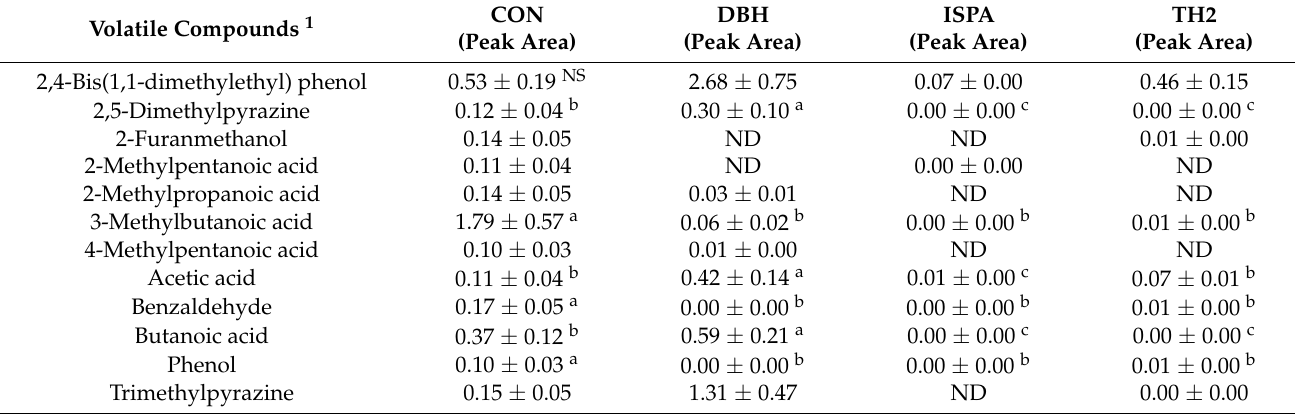
Table 5. Volatile compounds composition of commercial jeotgal (CON) and jeotgal alternatives (DBH, ISPA, and TH2). Volatile Compounds